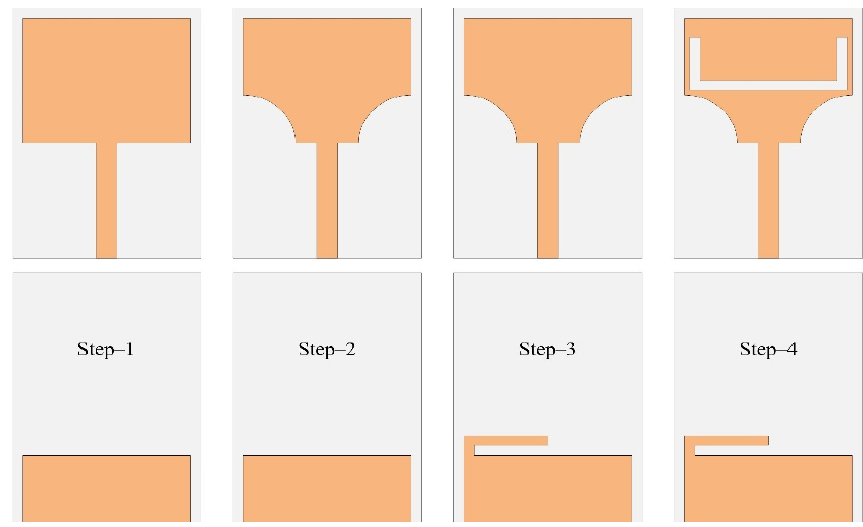
Figure 2. Design methodology steps of the proposed work.